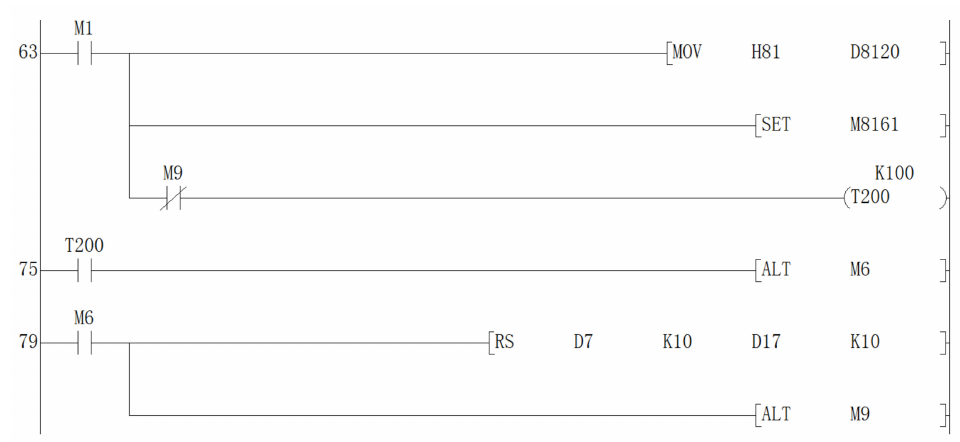
Figure A4. Ladder diagram of cutter angle